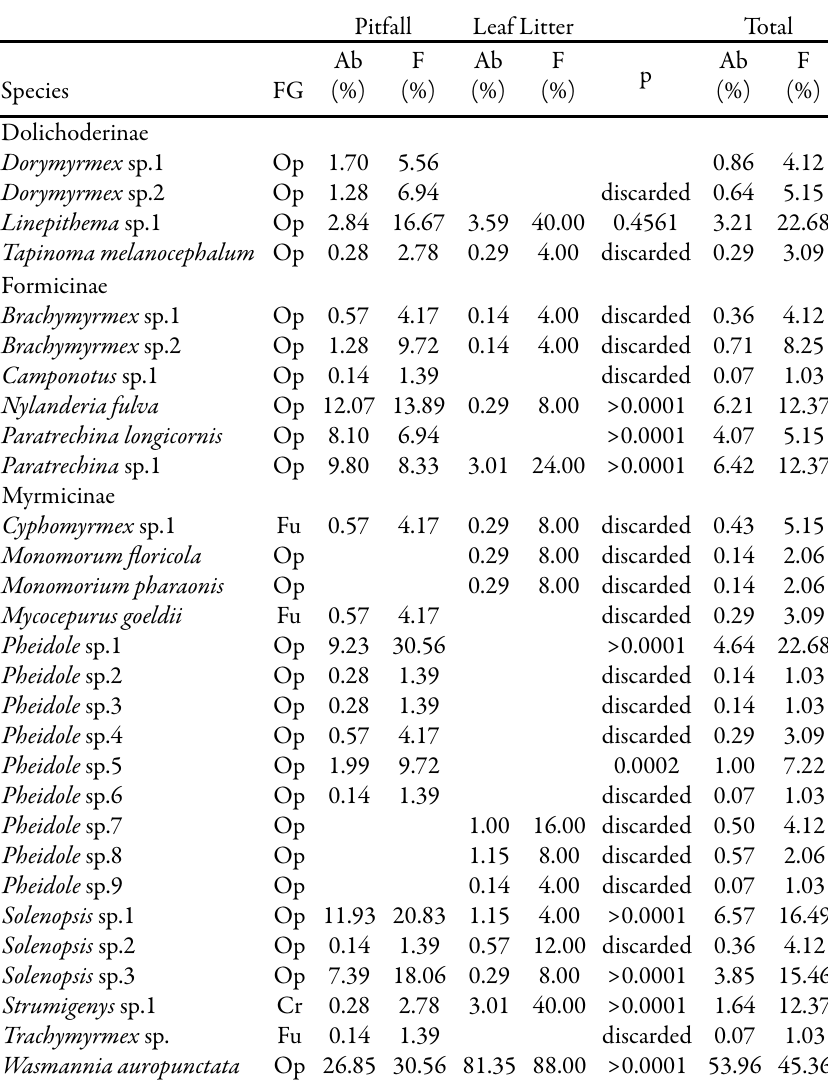
Table1. Relative abundance (Ab) and frequency (F) of ant species collected with pitfall traps and leaf litter samples, the comparison between the two sample methodologies (Chi-square test) and the clas- sification of species into functional groups (FG), where Op = opportunistic, Fu = fungus-growing, Cr = cryptic, Lp = Large predator and Ar = arboreal. Collections in the park of Instituto Biológico, São Paulo,